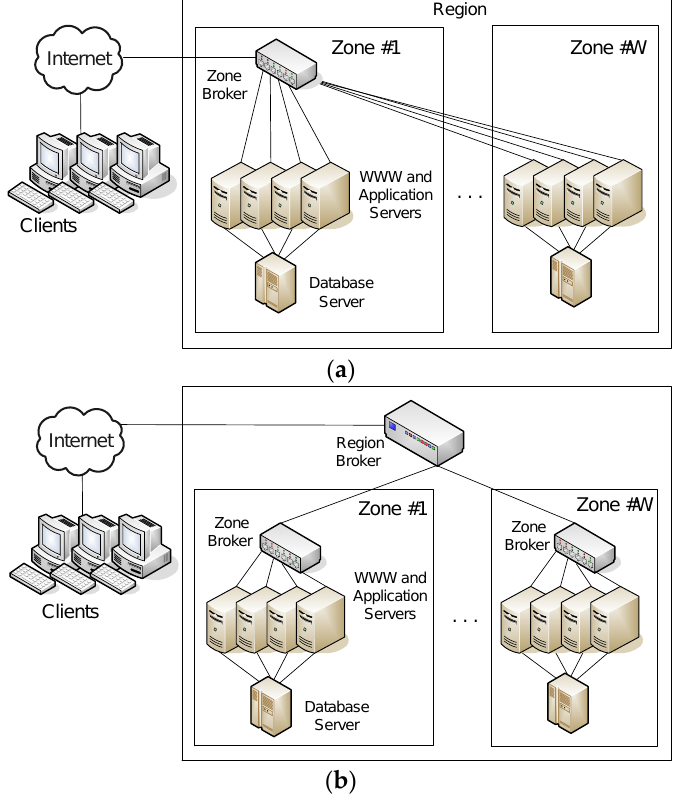
Figure 1. Cloud-base web systems: ( a ) centralized one-layer architecture and ( b ) distributed two- layer architecture.